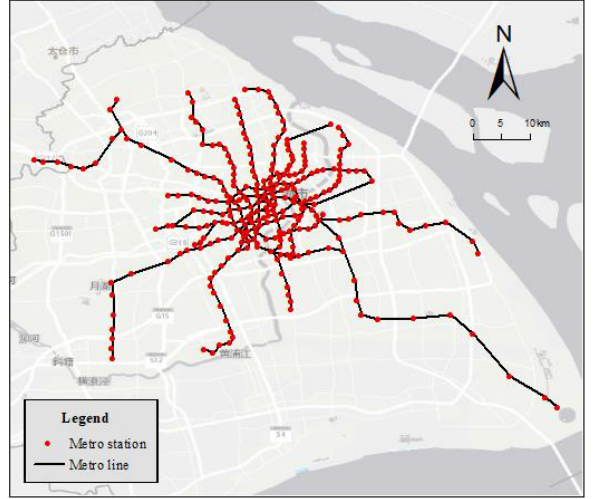
Figure 3 . Shanghai metro